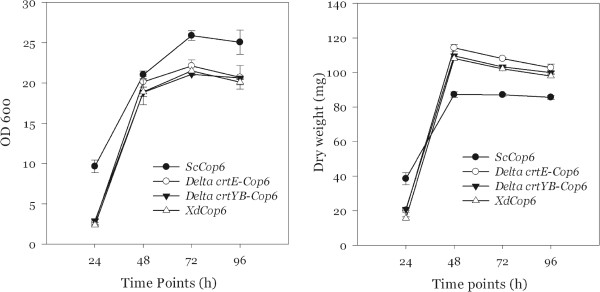
OD600 and cell dry weight of ScCop6, ΔE-Cop6, ΔYB-Cop6 and XdCop6 in 10 ml of YPD medium.